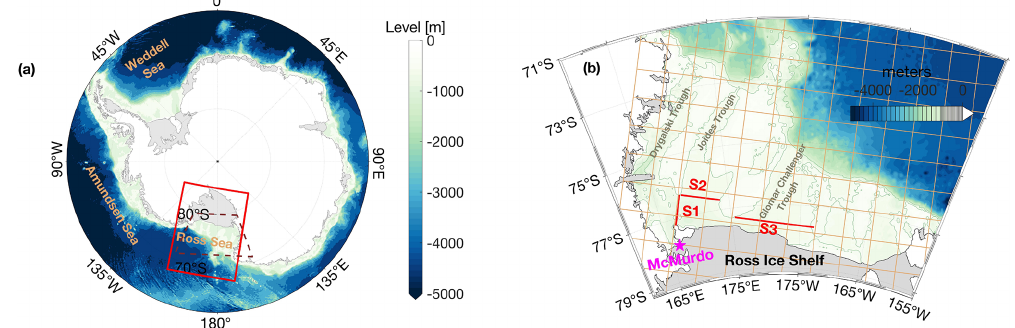
Figure 1. Geographic map of (a) the Southern Ocean south of 60 ◦ S, and (b) the Ross Sea. Areas in white show continental surfaces, and areas in light grey indicate the ice shelves. The color scale indicates the bathymetry. In panel (a) , the Ross Sea model domain is shown by the solid red box, and the dashed brown box represents the area shown in panel (b) . In panel (b) , the orthogonal yellow lines indicate the model grids magnified by a factor of 20, the magenta star indicates the position of McMurdo Station, and the red lines indicate the S1, S2, and S3 sections crossing the troughs that are the major passages for HSSW outflows towards the slope.